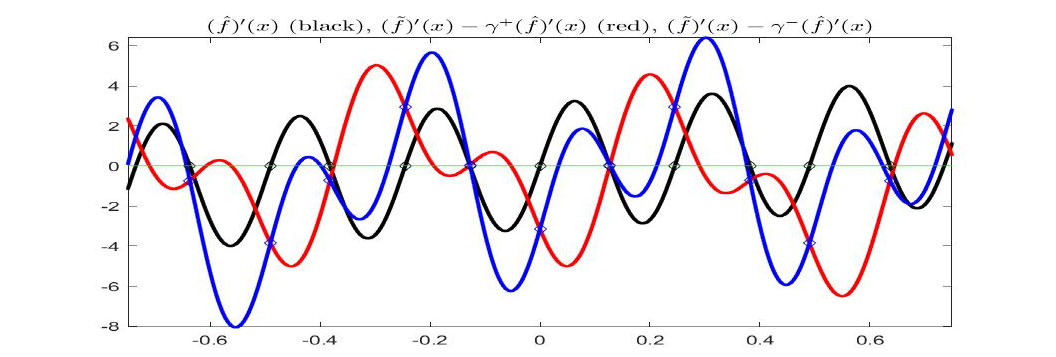
Figure 14. Complete Example: functions (cid:98) f (cid:48) ( x ) , γ + (cid:98) f (cid:48) ( x ) − (cid:101) f (cid:48) ( x ) , (cid:101) f (cid:48) ( x ) − γ − (cid:98) f (cid:48) ( x )